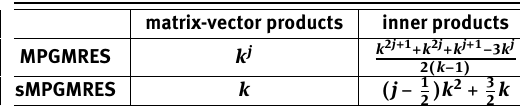
Table 1. Comparisons of computing